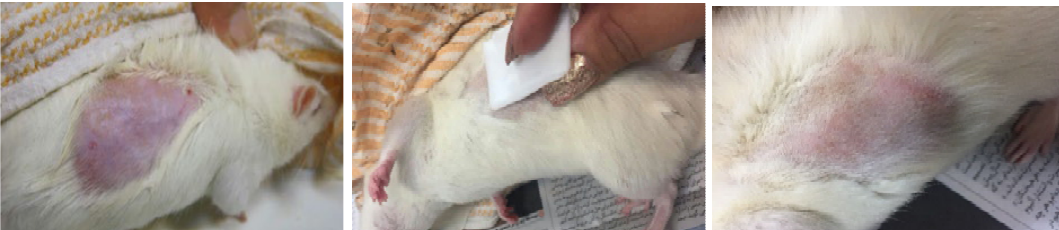
Fig.6: (A) Creating superficial burns with UV rays, (B) Rat dressed, (C) Burn recovery with burn dressing